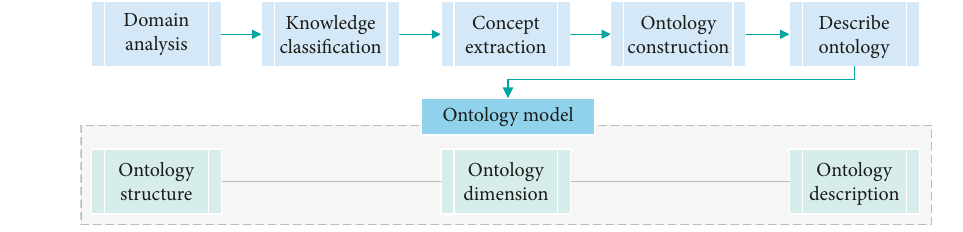
Figure 1: General process of building the ontology